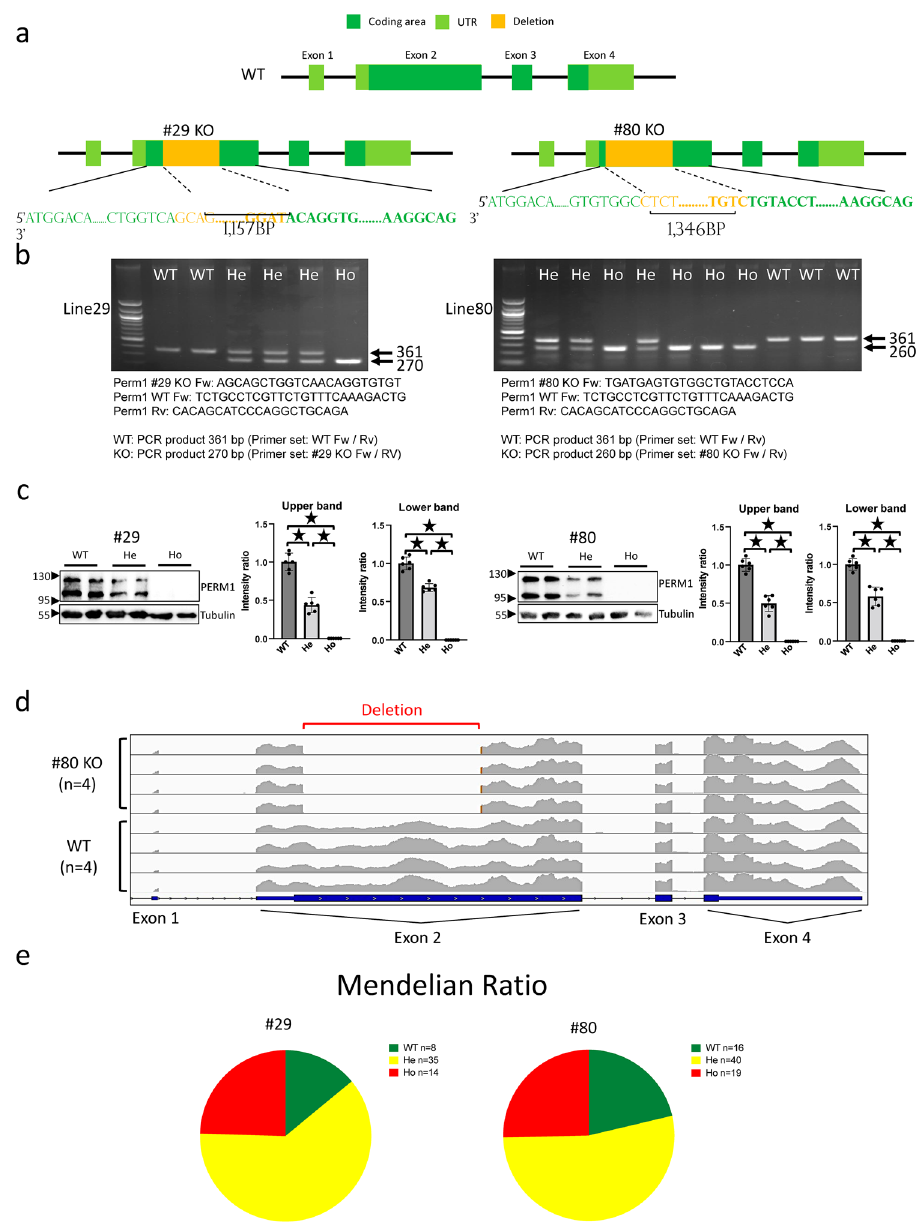
Figure 1. Perm1 knockouts displayed survival rate, Mendelian rule, and body weight growth similar to those of wild type. ( a ) Schematic representation of genomic DNA deletion in Line 29 and Line 80 Perm1 KO mice. The deletion sequence was designed in exon 2. ( b ) DNA electrophoresis for genotyping. Left panel shows 361 bp in WT mice and 270 bp in KO for Line 29 mice. Right panel shows 361 bp in WT and 260 bp for Line 80 mice. The primer sequences for genotyping are shown. ( c ) Western blot analysis of PERM1, with densitometry for WT, heterozygous KO (He), and homozygous KO (Ho) shown individually. Left panel: Line 29; Right panel: The statistical significance was determined with Student’s t test, *p < 0.05 was considered significant. Line 29: WT (3 male + 3 female); He (3 male + 3 female); Ho (3 male + 3 female). Line 80: WT (3 male + 3 female); He (3 male + 3 female); Ho (3 male + 3 female). ( d ) Exon level visualization revealing Perm1 mRNA partial exon 2 deletion in homogenous Perm1 KO mice. WT (2 male + 2 female); KO (2 male + 2 female). ( e ) Upper and lower panels show 2-month survival rates for Line 29 and Line 80 individually. Line 29: WT (4 male + 4 female); He (16 male + 19 female); Ho (6 male + 8 female). Line 80: WT (7 male + 9 female); He (21 male + 19 female); Ho (11 male + 8